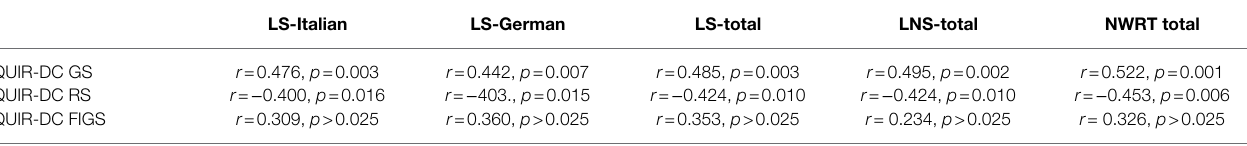
TABLE 6 | Correlations between children’s MuLiMi NW repetition performance at T1 and T2 ( n = 14). LS-Italian T2 NWRT total T2 LS-Italian T1